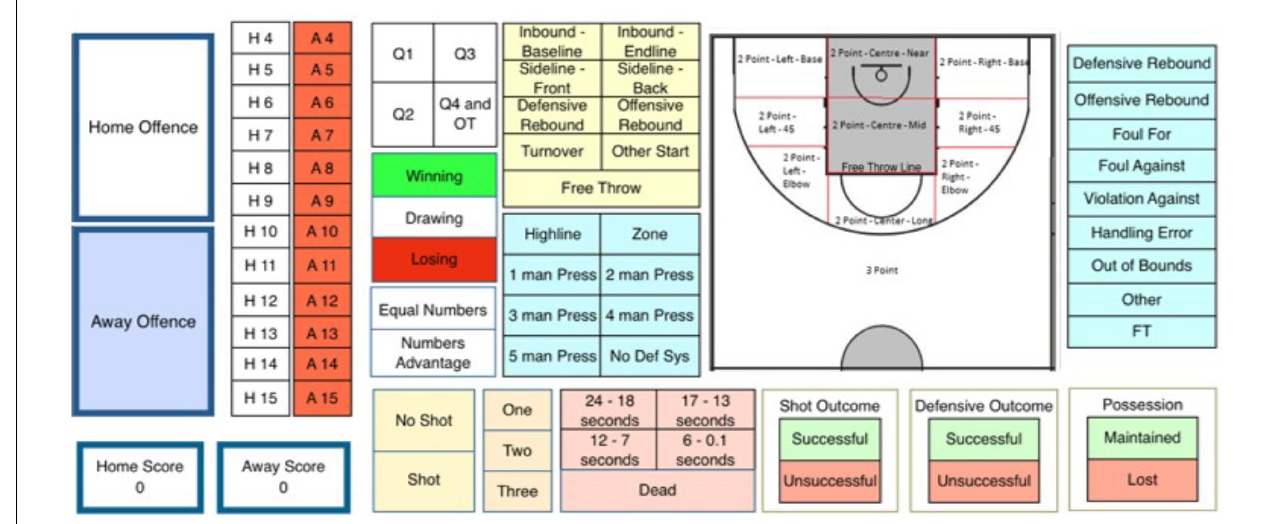
FIGURE 2 | Team performance analysis template for coding wheelchair basketball